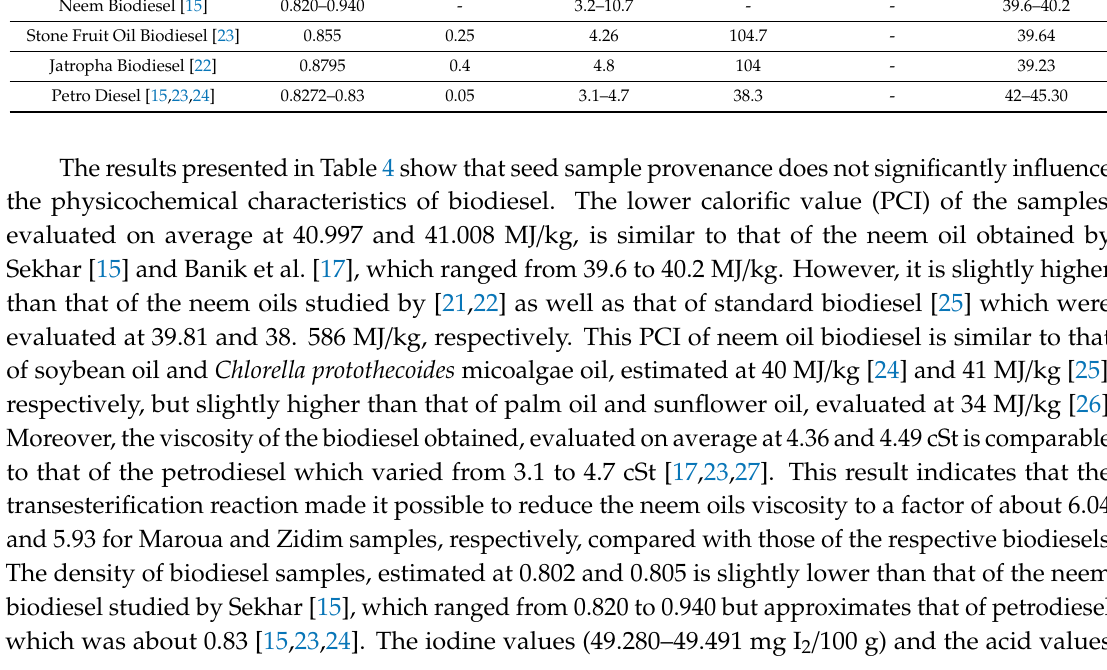
Kinematic Density at Acid Value Iodine Value Saponification Lower Calorific Viscosity at 25 ◦ C (mg / g) (mg I 2 / 100 g) Value (mg / g) Value (MJ / 40 ◦ C (cSt)